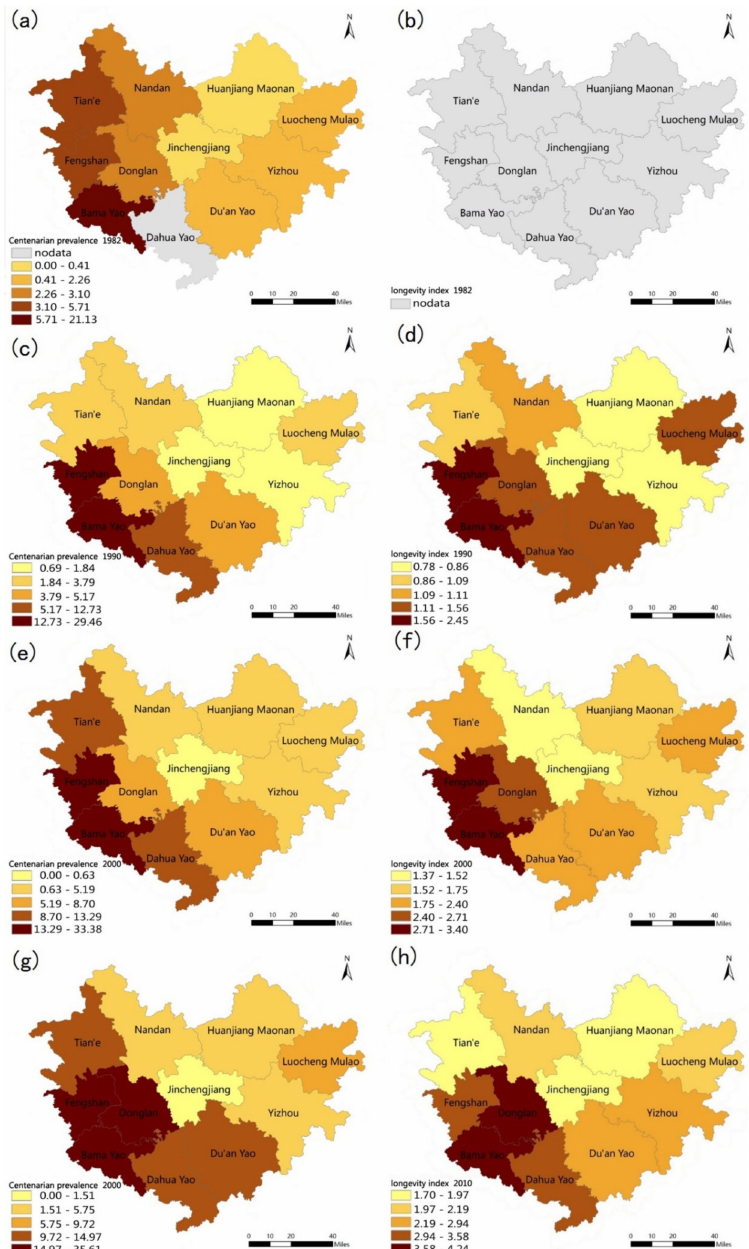
Figure 3. Distribution of the centenarian prevalence in 1982 ( a ), 1990 ( c ), 2000 ( e ) and 2010 ( g ) and the longevity index in 1982 ( b ), 1990 ( d ), 2000 ( f ) and 2010 ( h ) in